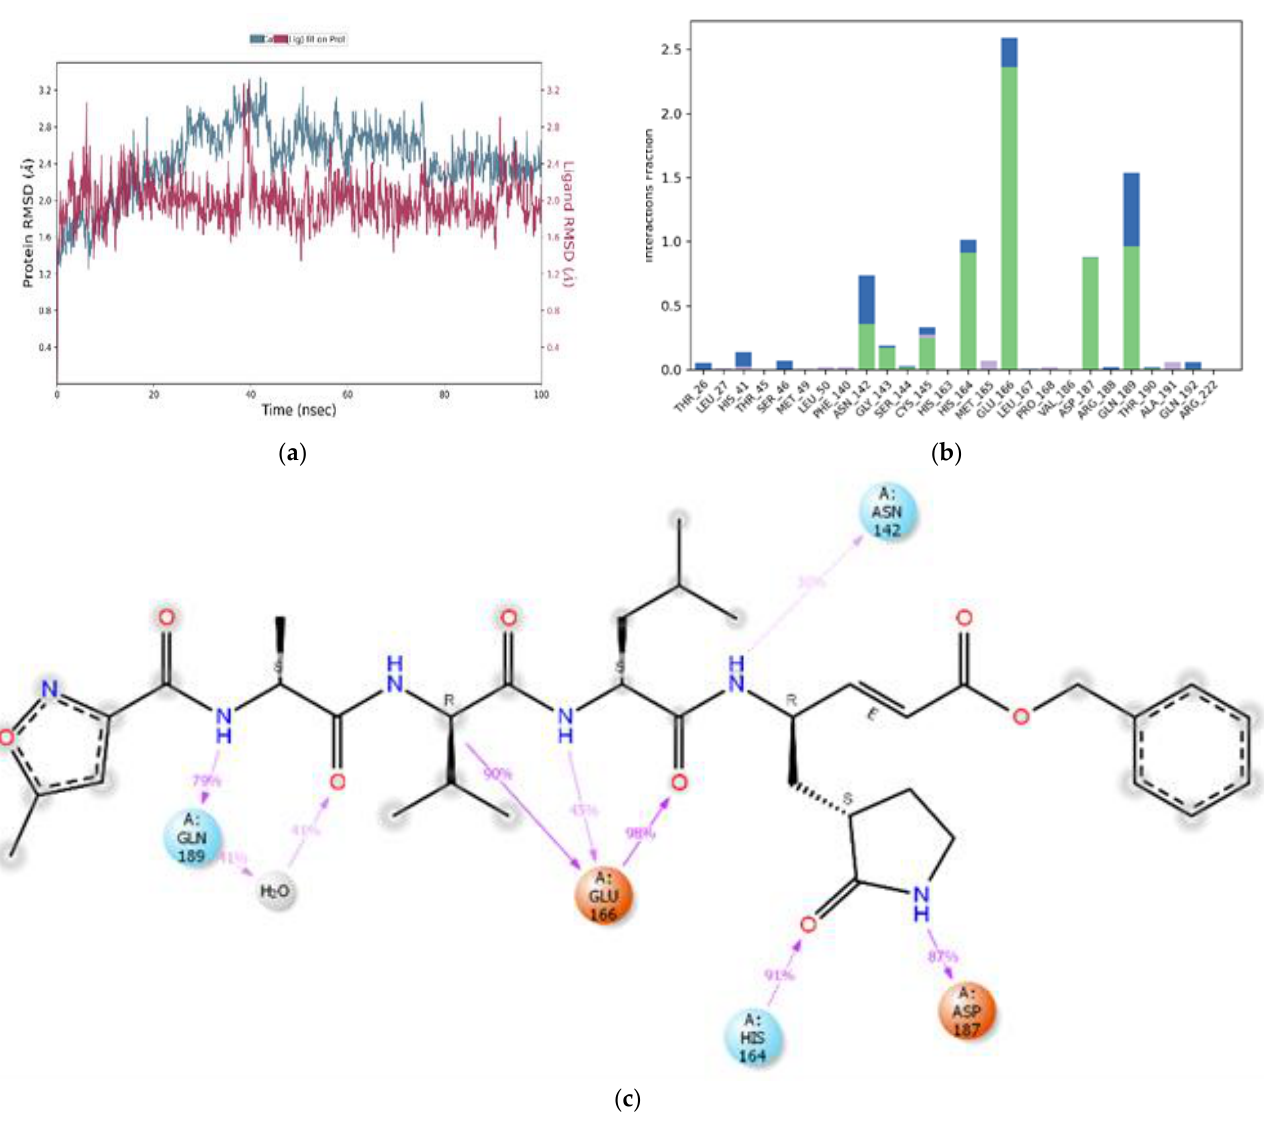
Figure 9. MD simulation studies of N3 (Reference 2) in complex with Mpro. RMSD plot of protein backbone (Cα) and protein conformational change during ligand binding ( a ). Interaction fraction plot showing different protein residues that interact with N3 during a 100 ns MD simulation ( b ). Interaction of ligand atoms with the protein residues that occurs for >70% of the simulation time (c).